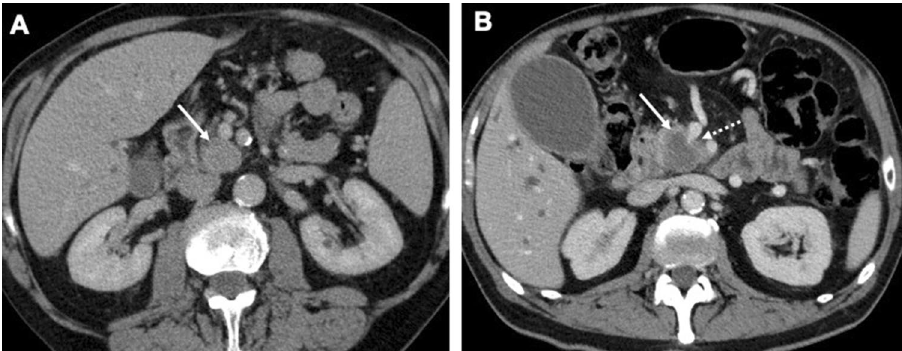
Figure 2. Comparison of CT features of ITPN with associated invasive carcinoma and PDAC. ( A ) Axial CT scan in the portal venous phase showing ITPN lesion in the pancreatic head (arrow) with well-circumscribed margins and isodense HU values. Note the preserved morphology and boundaries of the superior mesenteric vessels. ( B ) Axial CT scan of a different patient in the portal venous phase showing PDAC in the same location (arrow) showing unsharp margins, hypodensity und classical tear-drop sign of superior mesenteric vein (dotted arrow), suggesting its